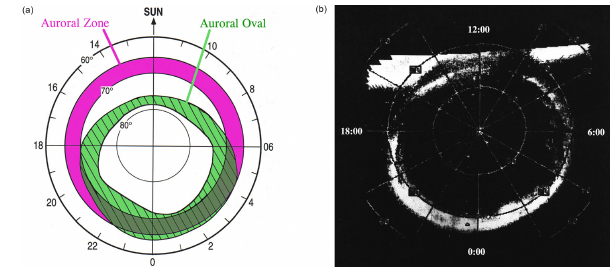
Figure 2. (a) Both the auroral zone and the auroral oval are shown in the geomag. lat. LMT coordinate for the purpose of comparison. (b) The first image of the auroral oval obtained by a Canadian satel- lite (Courtesy of C. Anger,